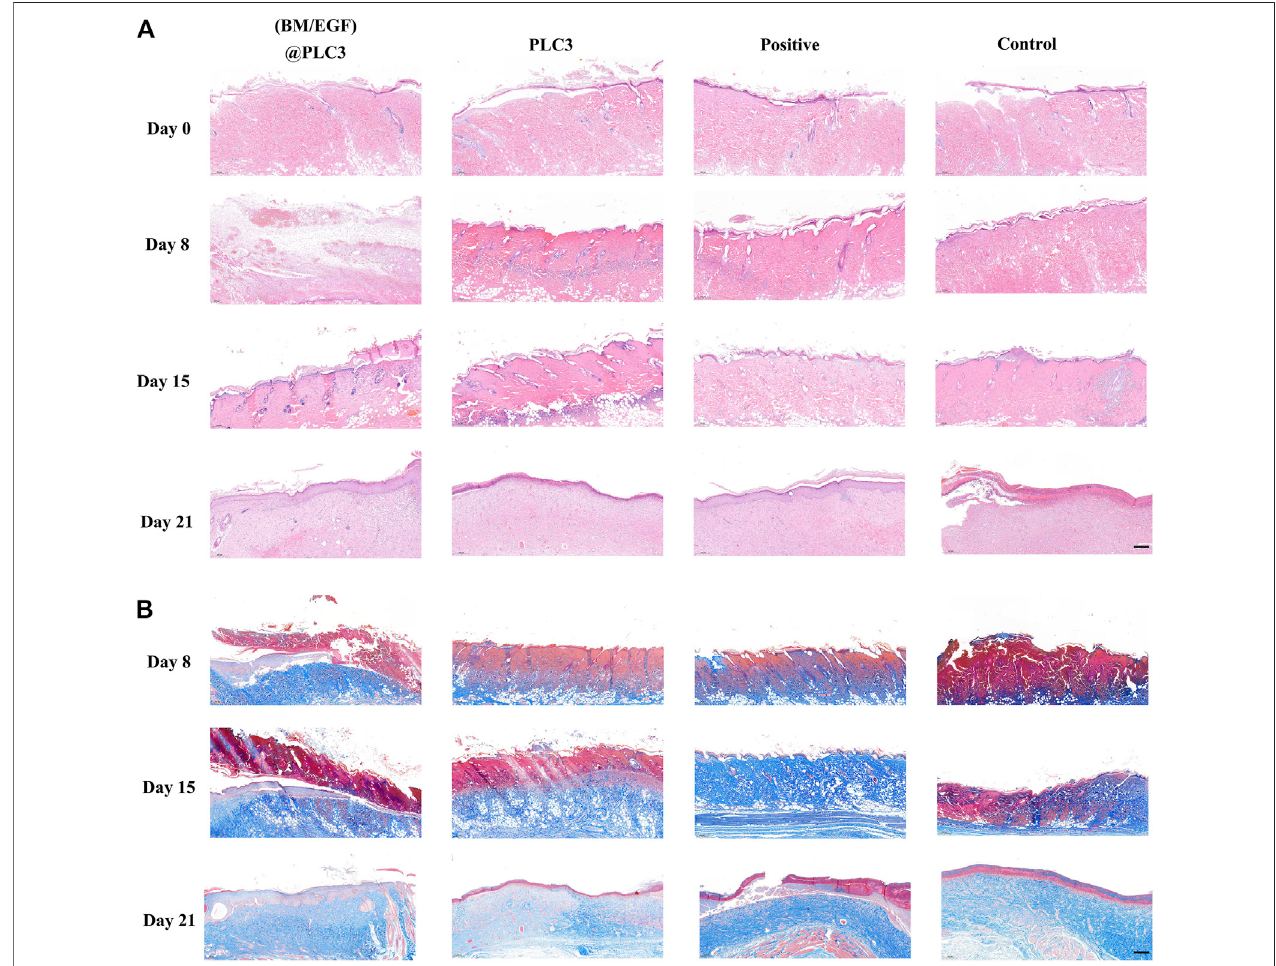
FIGURE7| Theresultofhistopathologicalexamination. (A) H&Estainingofsampledtissueondays0,8,15,and21. (B) Masson ’ strichromestainingofsampleson days 8, 15, and 21; scale bar: 200 µm.